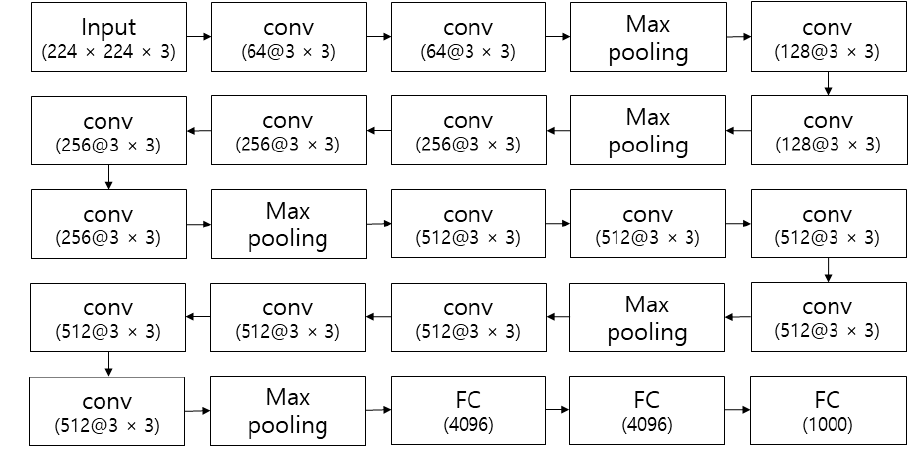
Figure 1. Structure of VGGNet. FC, fully connected.